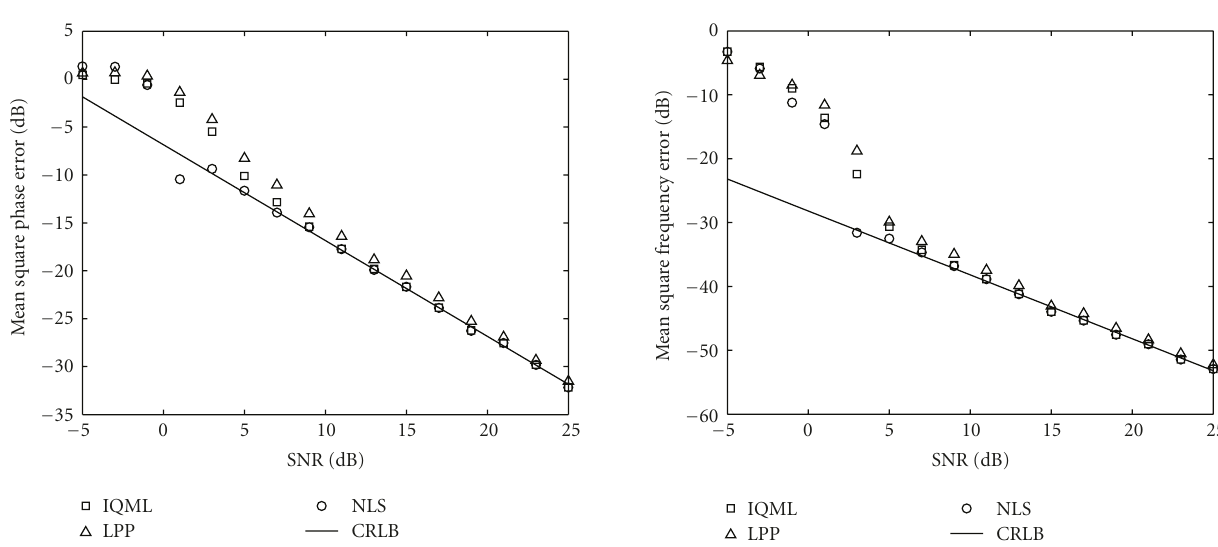
Figure 9: MSE for φ of single real sinusoid with fixed φ .